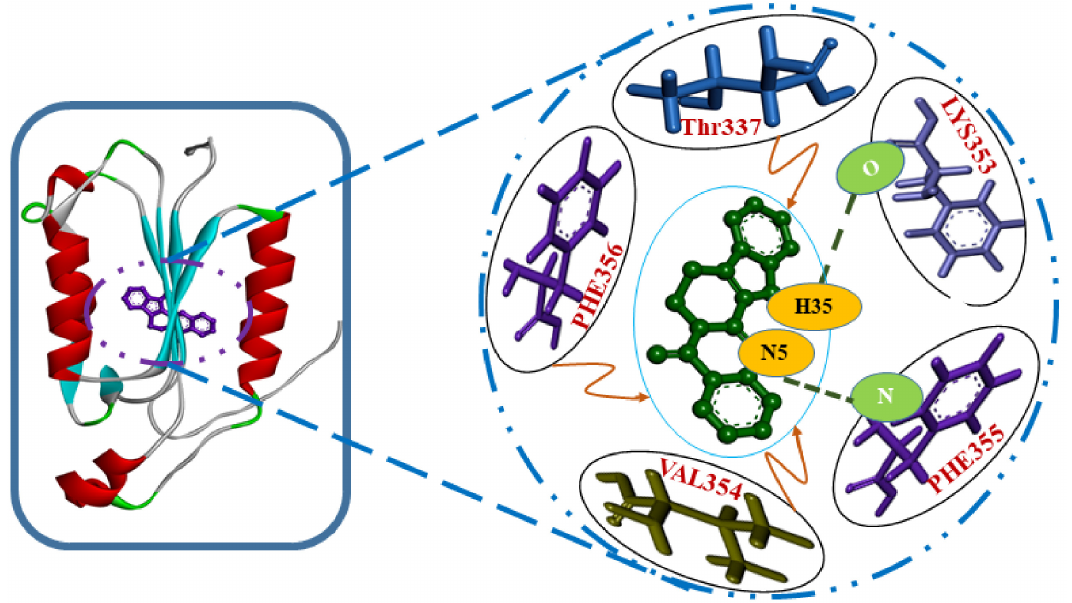
Figure 1. Lowest-energy docked structure of the caspase 8 / rutaecarpine complex. Hydrogen bonds are represented by bold dashed green lines.